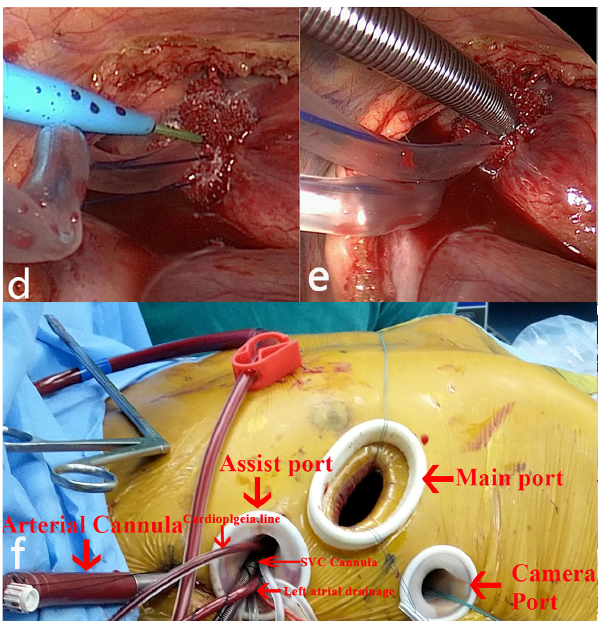
Fig. 2 – (d) Cannula introduced along the guidewire. (e) Aortic cannula adjusted and secured. (f) Schematic diagram of the surgical incision and cannula